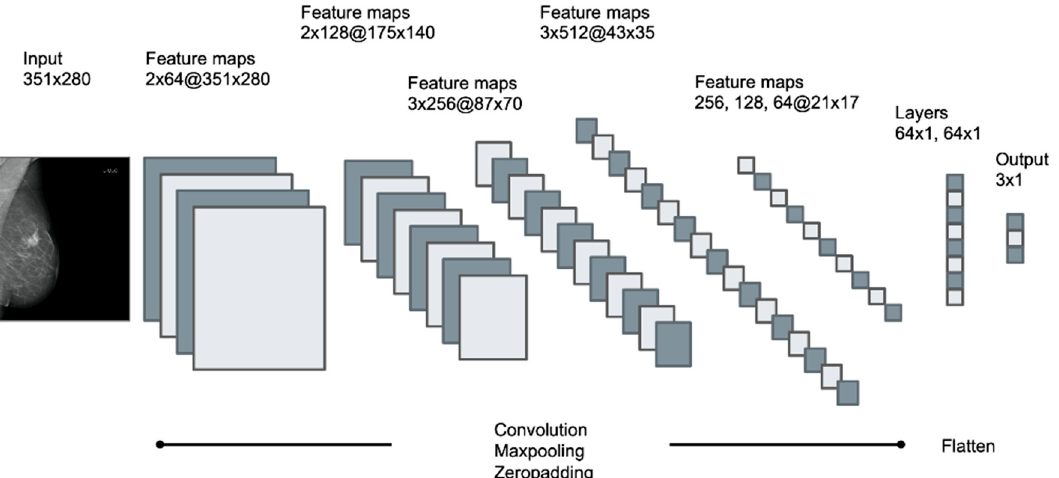
Figure 3. Schematic pattern of the applied multilayered deep convolutional neural network (dCNN), containing 13 convolutional layers with 4 max pooling layers followed by 2 dense layers. Input size of the image was 351 × 280 for dCNN models 1–3 and 175 × 140 for dCNN model 4. Feature maps are described as the number of layers x number of kernels at(@) the resolution of the images.